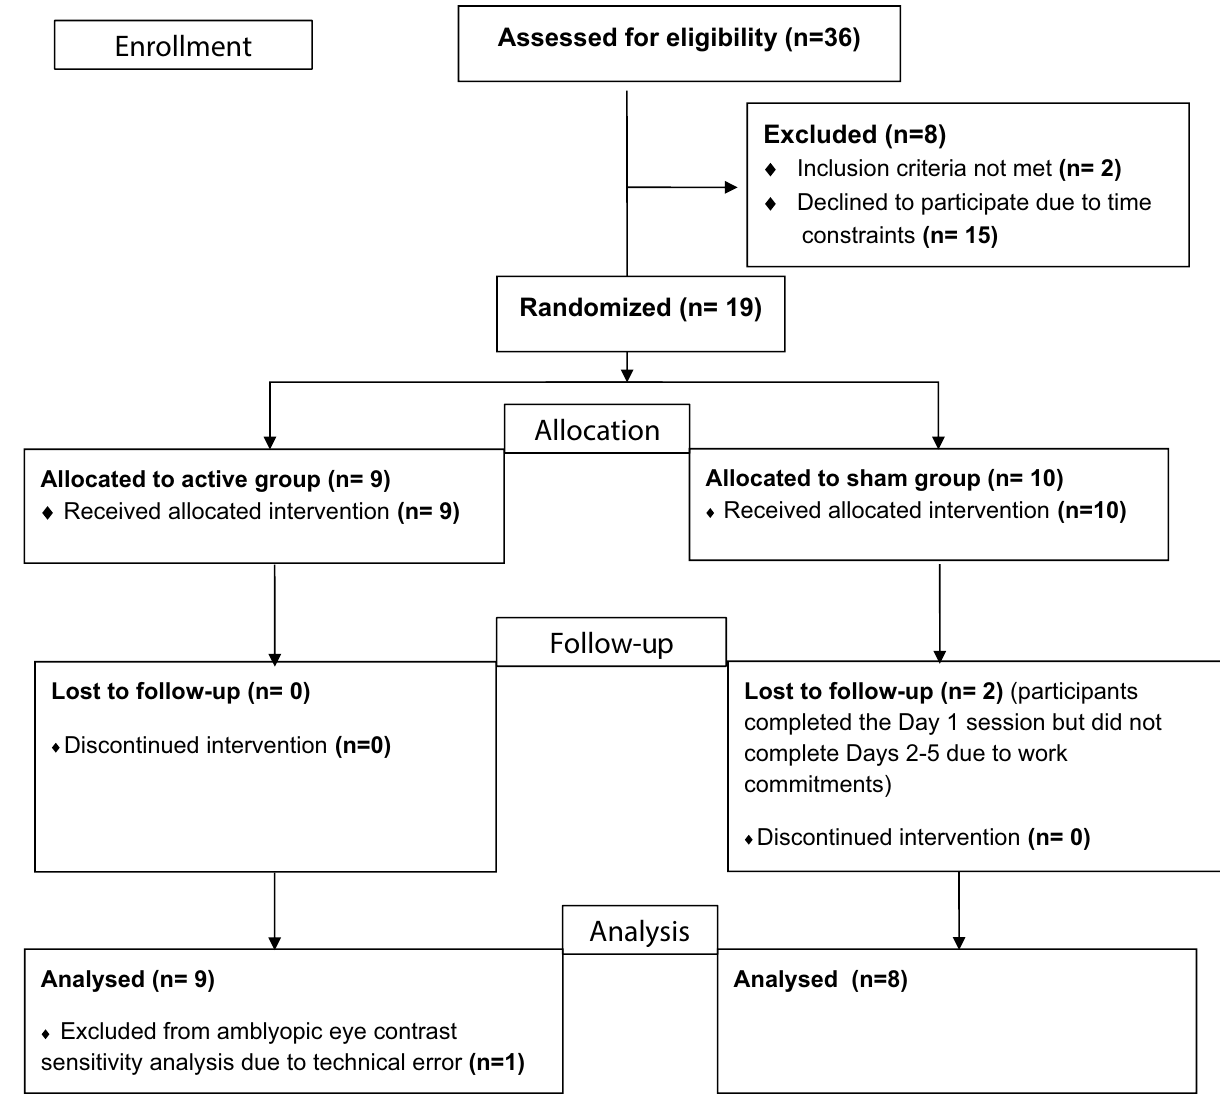
Figure 2. CONSORT flow diagram for the